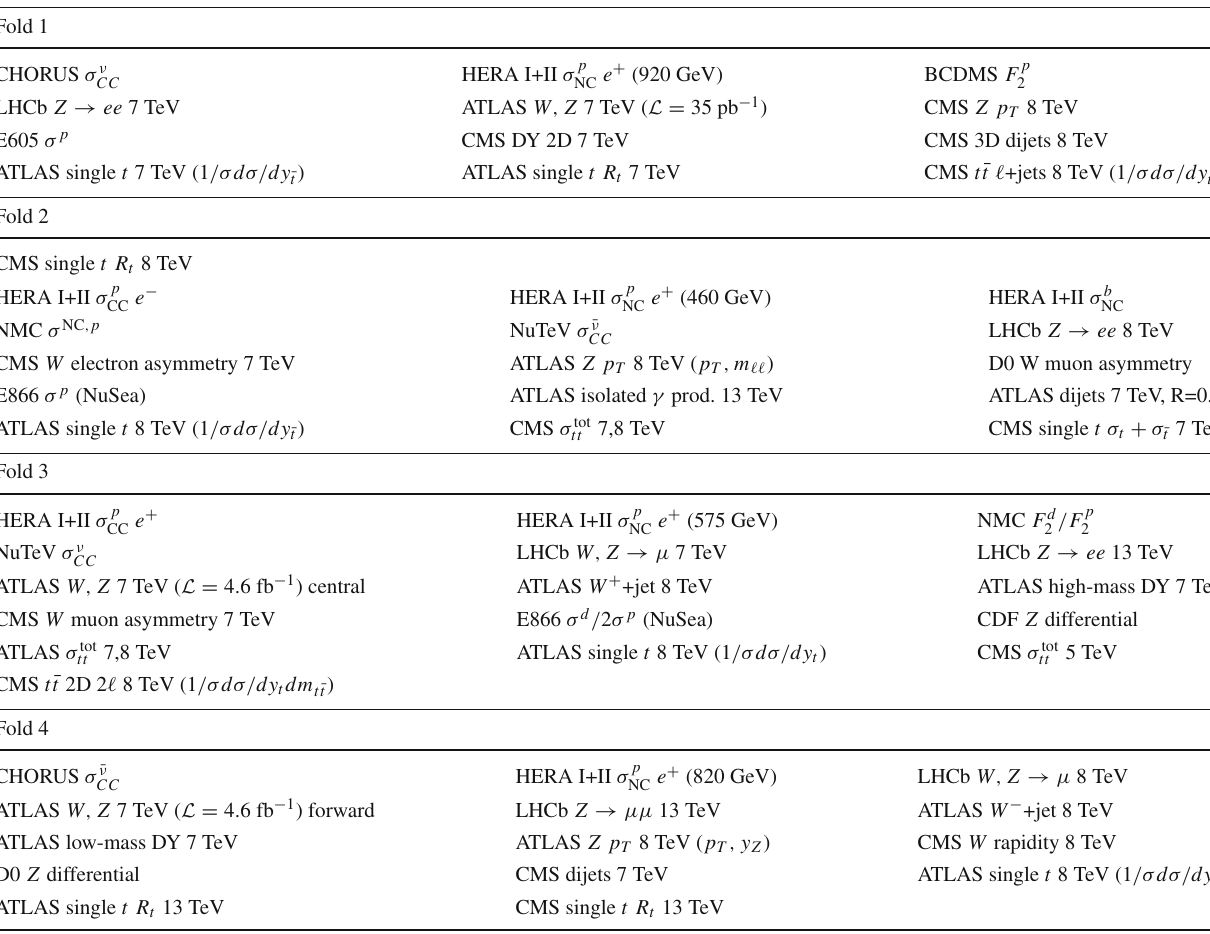
Fig. 8 Comparison between the gluon (left) and antidown (right) PDFs at Q = 1 . 65 GeV found by using methodologies in which hyperparameters are selected based on the “average” loss function Eq. (3.18) (green) or the “max” loss function Eq. (3.20) (orange) Table 8 The four folds in which the NNPDF4.0 dataset is divided for the k -folds hyperoptimisation procedure represented in Fig.